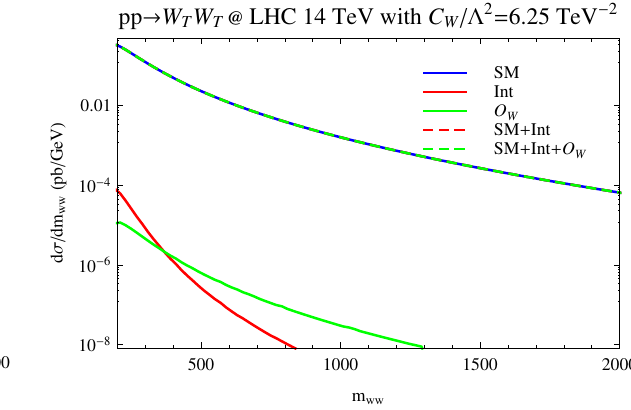
Figure 4. Invariant mass distributions for the production of two transversely polarized W bosons with the same color convention as in Fig.